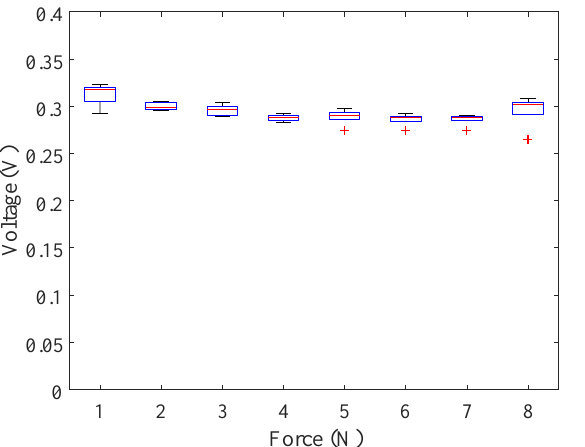
Figure 3. Voltages recorded at an electrode for different contact forces. The distance between the electrode and touched location was 12.8 cm. Five voltage values were recorded for each